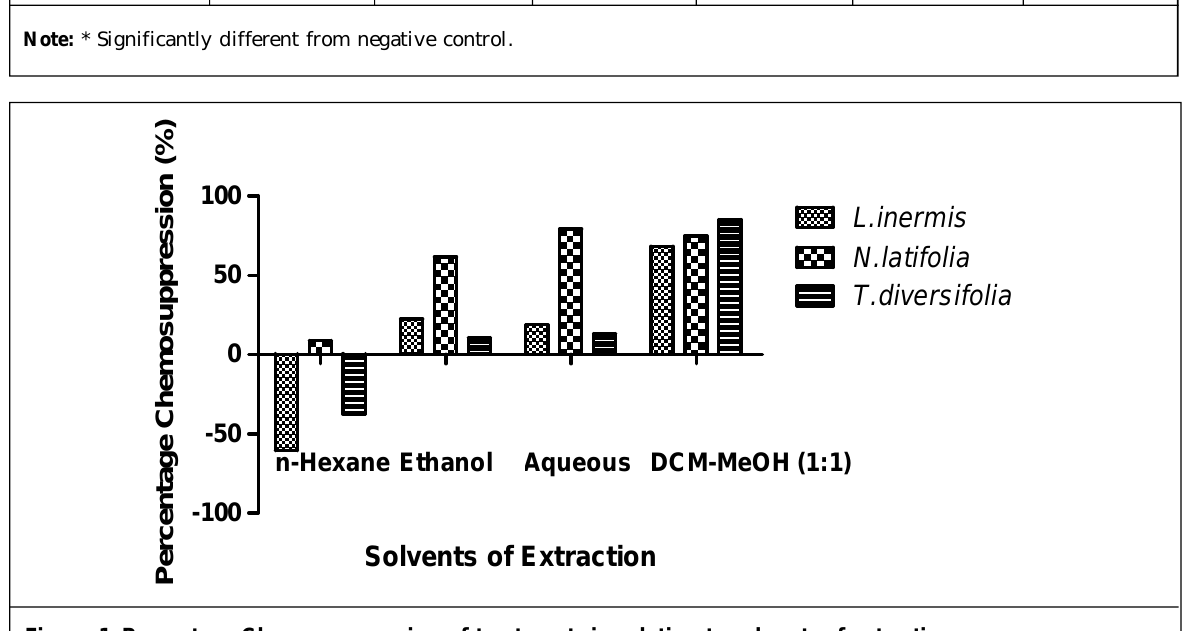
Figure 1: Percentage Chemosuppression of treatments in relation to solvents of extraction on day 4 post-infection and